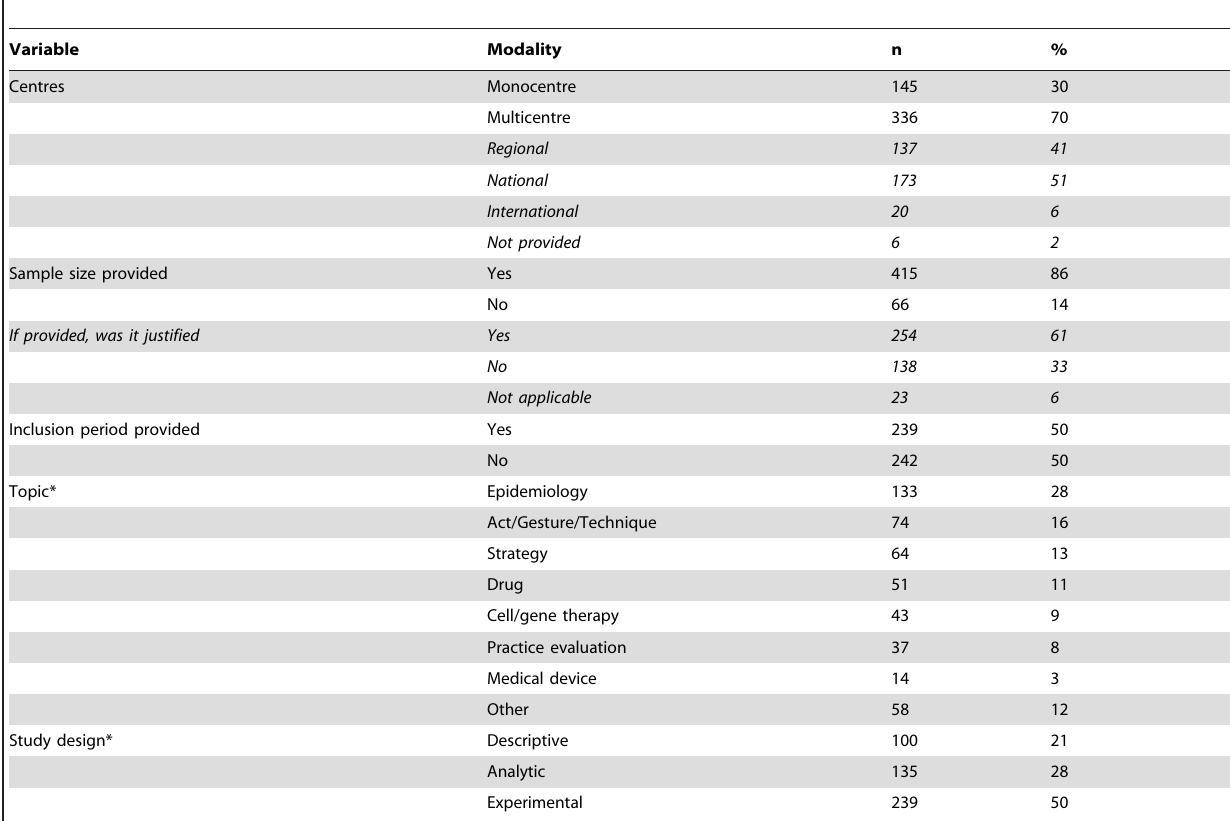
Table 1. Initial characteristics of protocols submitted to the PHRC 2000 funding scheme